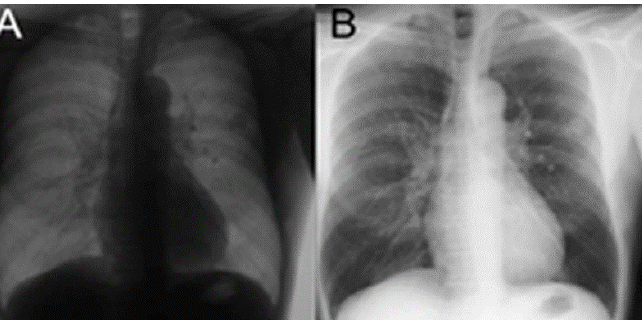
Figure 3. Example of the same image with inverse grayscale. ( A ) The CXR with inverse grayscale. ( B ) The corrected CXR after monochrome correction.